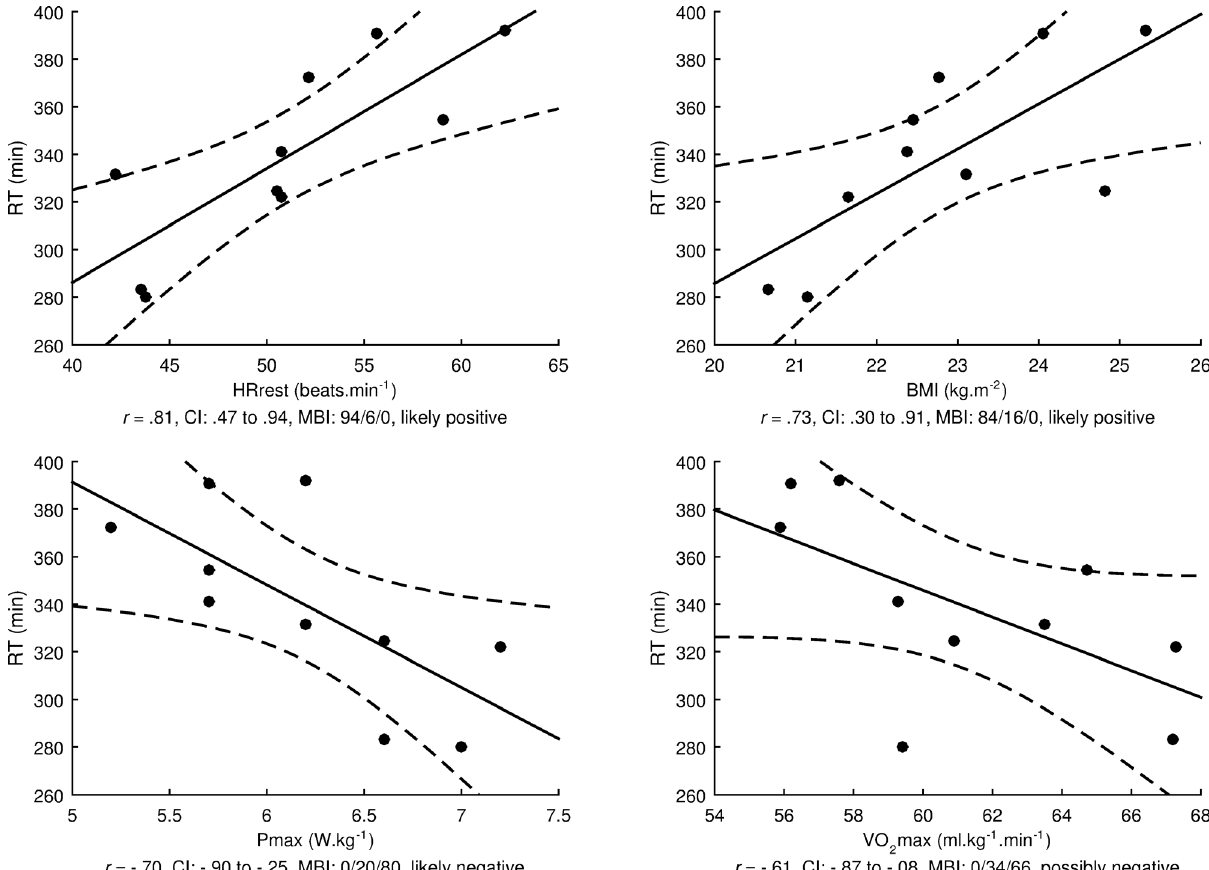
Figure 3. Correlation analysis between race time (RT) and selected variables. Dashed lines denote 0.90-confidence area. HRrest = morning heart rate in the supine position on the day of the race; BMI = body mass index; Pmax = max- max = maximal oxygen uptake; r = Pearson’s correlation coefficient; CI = 0.90-confidence imal power output; VO 2 interval for r ; MBI = magnitude based inference that evaluates the chances that the true value of r is substantially positive, trivial, or substantially